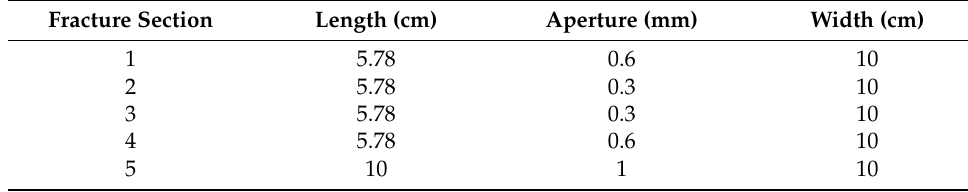
Table 3. Basic information about the fracture section.